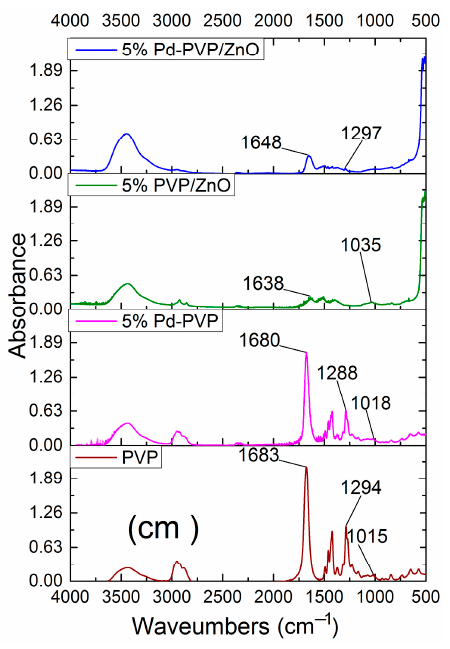
Table 2. BET surface area of the ZnO, 0.5%Pd/ZnO, PVP/ZnO, and 0.5%Pd-PVP/ZnO samples.